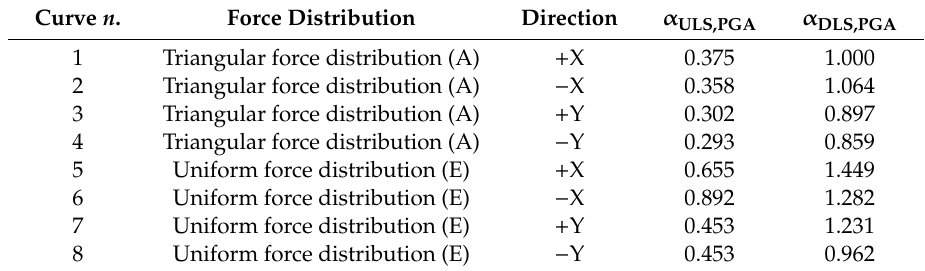
Table 3. Safety indices obtained for the ultimate limit state ( α ULS,PGA ) and the damage limit state ( α DLS,PGA ). Curve n